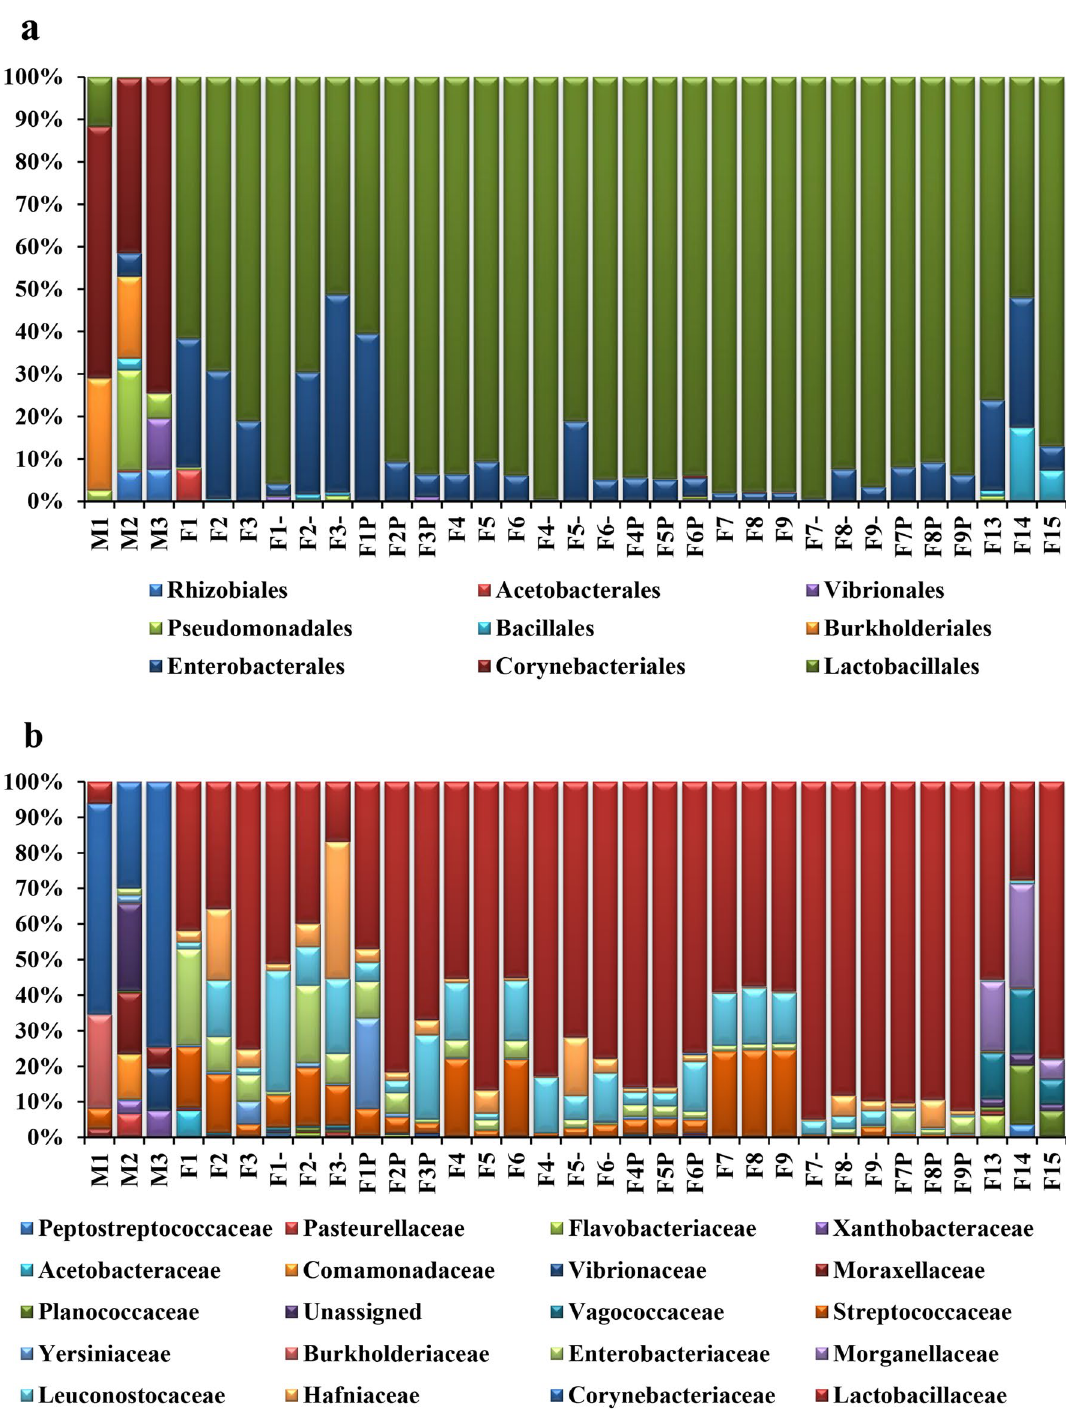
Figure 5. Bacterial diversity composition for the decomposed liver samples: ( a ) Order; ( b ) Family (sample symbols, except control: “–” liver inoculated with 10 2 S. enterica concentration; “P” liver inoculated with 10 4 S. enterica